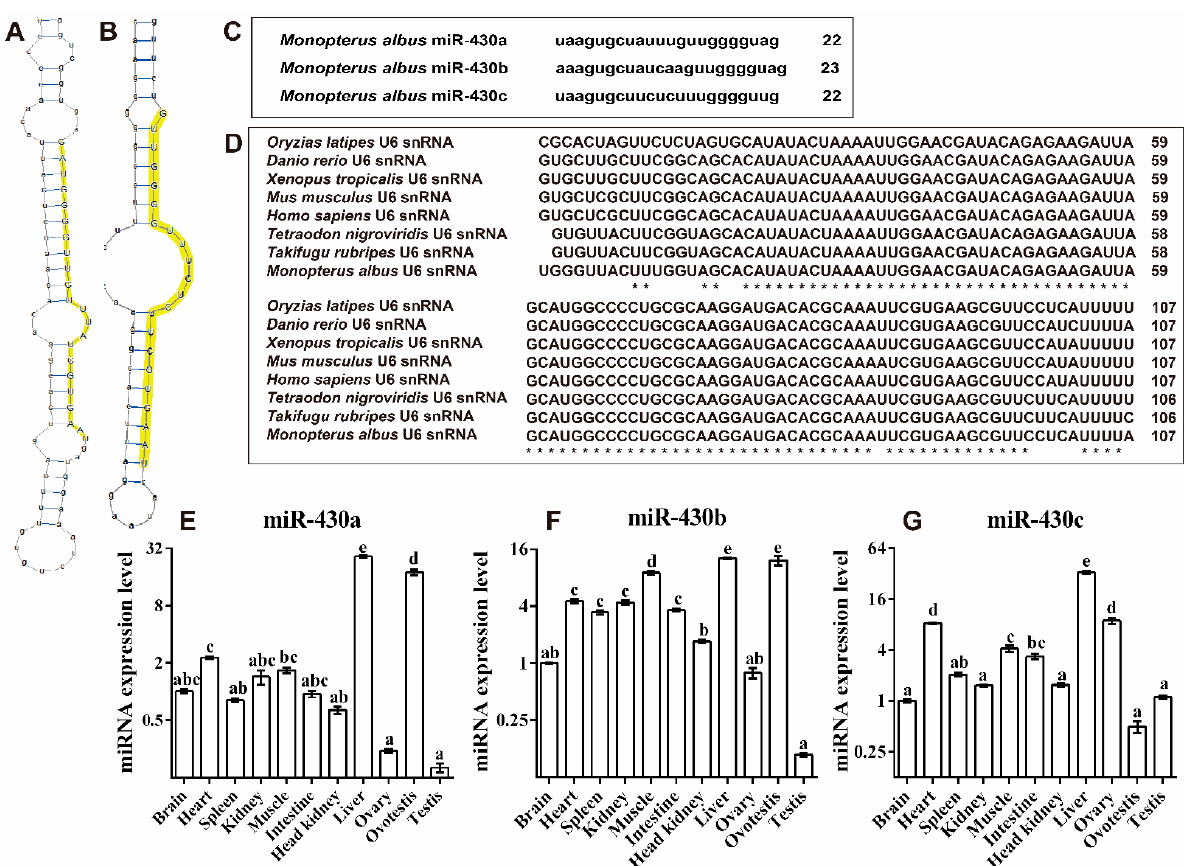
Figure 4. Identification of miR ‐ 430 family in rice field eel. Predicted secondary structures of miR ‐ 430a ( A ) and miR ‐ 430c ( B ) precursors in rice field eel. Representatives of each of two miR ‐ 430 groups are shown. Yellow shadings indicate mature regions and seed sequences, respectively. ( C ) miR ‐ 430 (a, b, c) sequences in rice field eel. ( D ) ClustalX alignment of the U6 snRNA from M. albus and other species. The star (*) represents the identical nucleotides. ( E – G ) The miRNA expression level of miR ‐ 430 in the brain, heart, spleen, kidney, muscle, intestine, liver, ovary, ovotestis, and testis. Data (mean ± SEM, n = 3) were normalized to the housekeeping gene (U6 snRNA). Bars that do not share a letter are significantly different among different tissues ( p < 0.05).